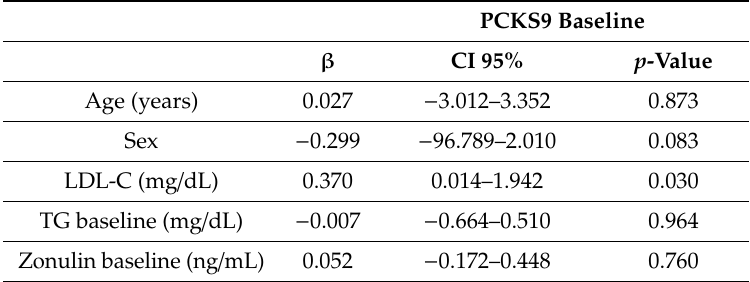
Table 3. Multiple linear regression analysis for baseline